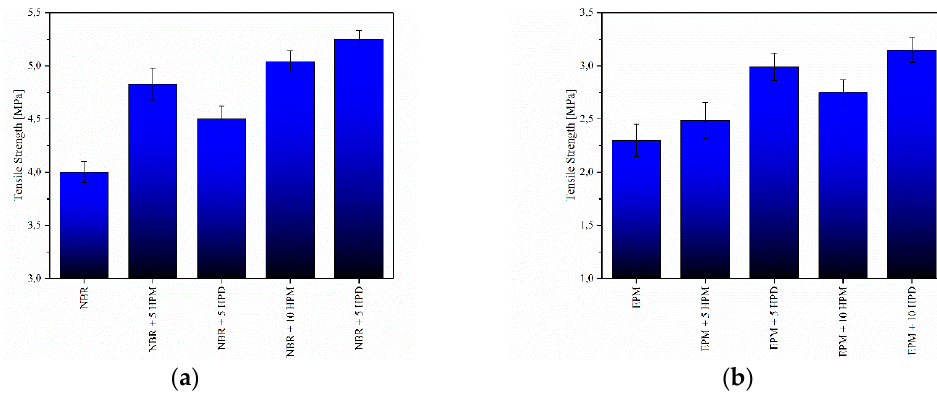
Figure 10. Tensile strength of ( a ) NBR and ( b ) EPM compounds filled with hybrid pigments.